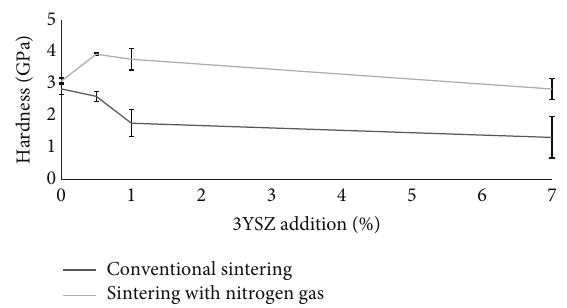
Figure 11: Hardness of HA/3YSZ nanocomposites prepared using two different sintering